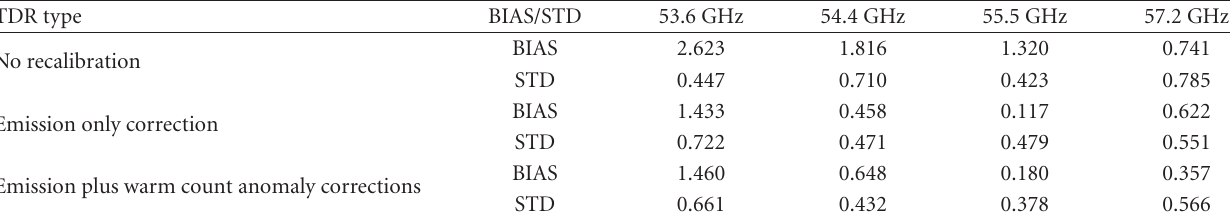
Table 3: Biases and standard deviation (STD) characteristics of brightness temperature di ff erences between F16 SSMIS and NOAA 16 AMSU from SCO measurements at four